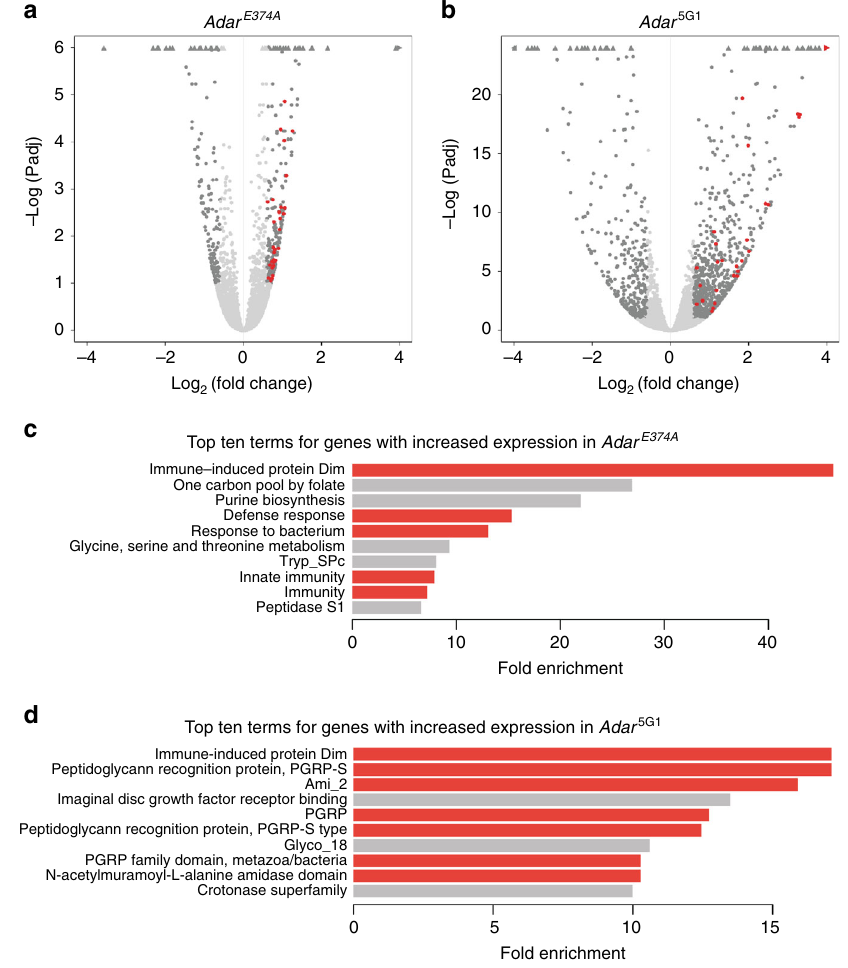
Fig. 4 Immune gene transcripts in Adar mutant heads. a Volcano plot (-log(adjusted p value) vs. log 2 (fold change)) for Adar E374A vs wild type RNAseq. b Volcano plot (-log(adjusted p value) vs. log 2 (fold change)) for Adar 5G1 vs wild type RNAseq. a , b Dark gray points indicate genes that are signi fi cantly differentially expressed (DESeq2 10% FDR; abs(log 2 (fold change)) > = 0.6). Red points indicate genes signi fi cantly differentially expressed that have immune-related GO terms (highlighted in red in c ). Triangles indicate points that lie outside the plotted area shown. Less than 0.5% of the points lie outside the plotting area. c The top 10 out of 27 signi fi cantly enriched terms for genes that are signi fi cantly overexpressed in the Adar E374A mutant. Bars are colored red for immune-related terms. (DESeq2: 10% FDR; DAVID: log 2 FoldChange > = 0.6, Benjamini adjusted p -value < 0.01) The terms used in the analysis are the DAVID default terms (biological process, molecular function, and cellular component GO terms, clusters of orthologous groups (COG), UniProt keywords and sequence features, Kyoto Encyclopedia of Genes and Genomes (KEGG) pathways, InterPro, Protein Information Resource (PIR) superfamily, and SMART). d The top 10 out of 84 signi fi cantly enriched terms for genes with increased expression in the Adar 5G1 mutant. Bars are colored red for immune-related terms. “ PGRP ” is “ Peptidoglycan recognition protein. ” (DESeq2: 10% FDR; DAVID: log 2 FoldChange > = 0.6, Benjamini adjusted p -value < 0.01) The terms used in the analysis are the same as in ( c